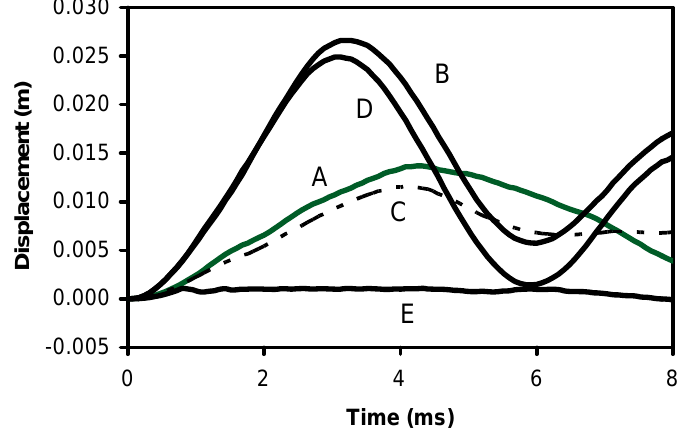
Fig. 9. Displacements at selected points on the outer skin plate.